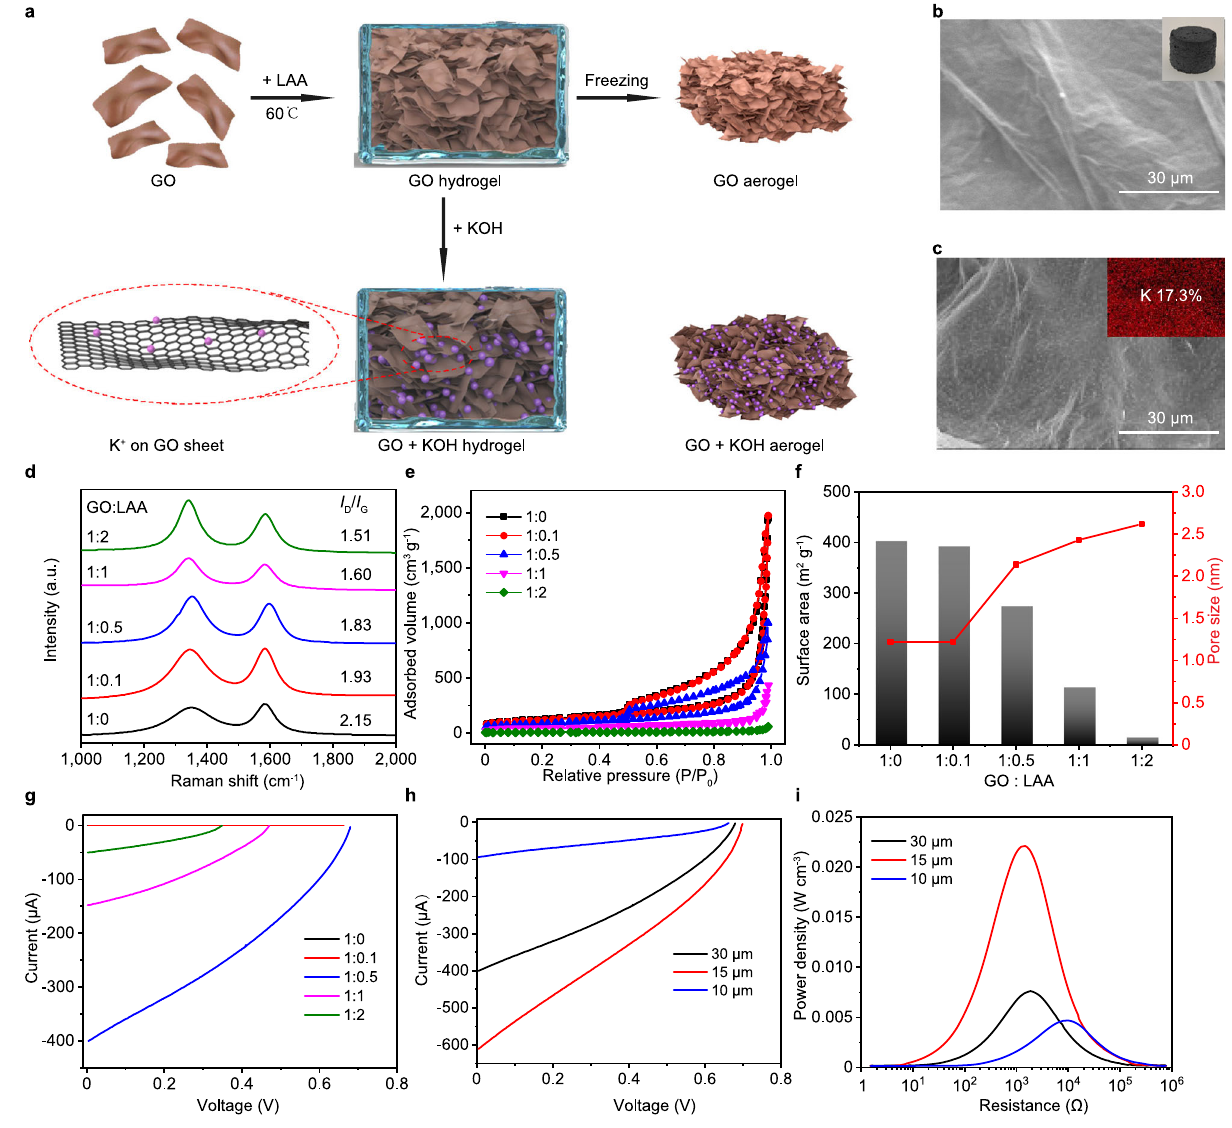
c SEM image of the GO+KOH aerogel. Inset is the EDS element mapping of the GO+KOHaerogel. d – f TheRamanspectroscopy( d ),BETtests( e ),surfaceareaand pore size ( f ) of GO aerogels with different GO:LAA ratio. g , h I – V characteristics of powersourceswithGO aerogelsthathavedifferentGO:LAAratio( g )andthickness ( h ). i Power density of the power sources with different GO aerogel thickness. Source data are provided as a Source Data fi